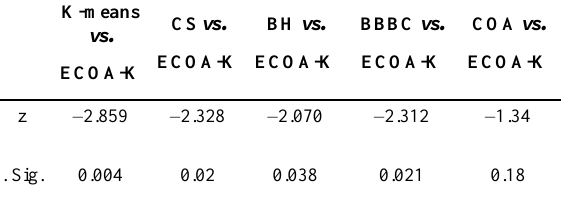
Table 9. Results obtained by statistical analysis of algorithms based on purity criteria on wine dataset. K-means vs.